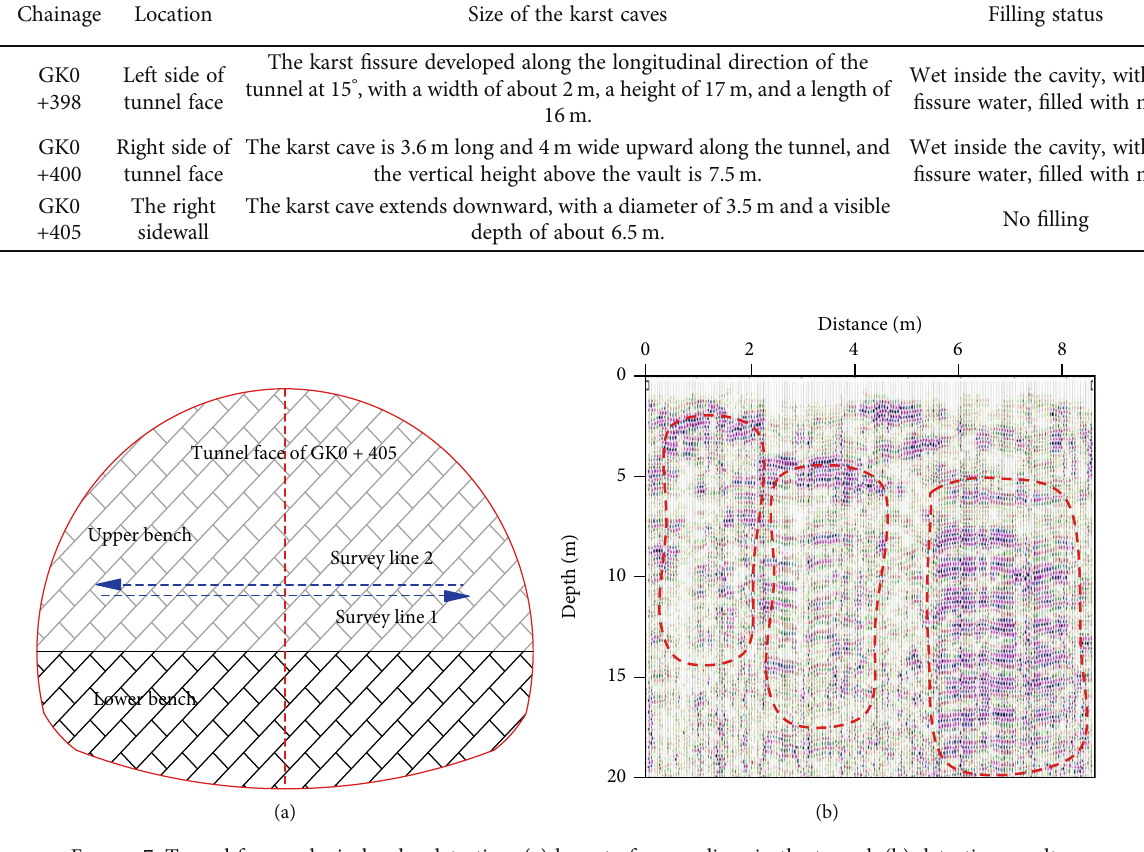
Figure 7: Tunnel face geological radar detection: (a) layout of survey lines in the tunnel; (b) detection result.